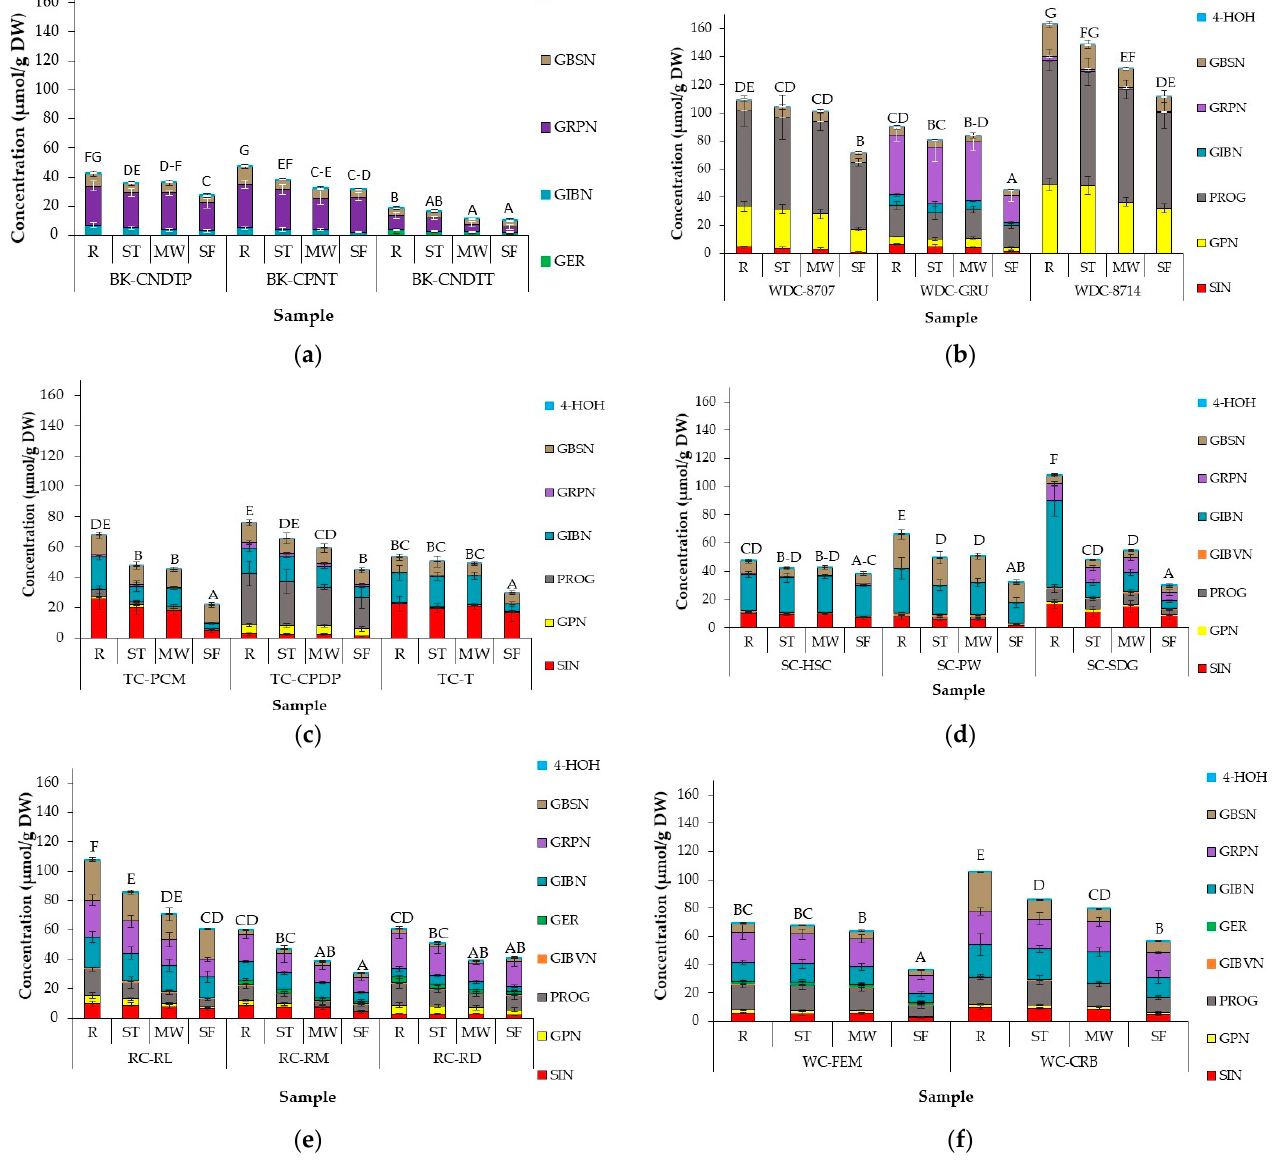
Figure 2. Glucosinolate concentrations (µmol/g DW) in different accessions of ( a ) Black kale; ( b ) Wild cabbage ( c ) Tronchuda cabbage; ( d ) Savoy cabbage; ( e ) Red cabbage and ( f ) White cabbage before and after domestic processing. Error bars represent standard deviation from mean values. Letters above bars refer to differences in total GSL concentration. Letters ‘A–G’: bars not sharing a common uppercase letter differ significantly ( p < 0.05) between accession and cooking conditions within a cabbage morphotype (i.e., within each separate graph). For significant differences between cabbage morphotypes, accessions, and cooking methods (i.e., across the separate cabbage morphotype graphs) see Supplementary Table S4. Abbreviations: R = raw, ST = steamed; MW = microwaved; SF = stir-fried; BK-CPNT: cavolo palmizio; BK-CNDTT: cavolo nero di toscana o senza testa; WD-8707: wild cabbage 8707; WD-GRU: wild cabbage 7338; WD-8714: wild cabbage 8714; TC-PCM: penca mistura; TC-CPDP: penca povoa; TC-T: tronchuda; SC-HSC: hybrid savoy wirosa; SC-PW: pointed winter; SC-SDG: dark green; RC-RL: red langendijker; RC-RM: rocco marner (Hybrid); RC-RD: red Danish; WC-FEM: early market; WC-CRB: couve repolho. For abbreviations of compounds, see Table 1